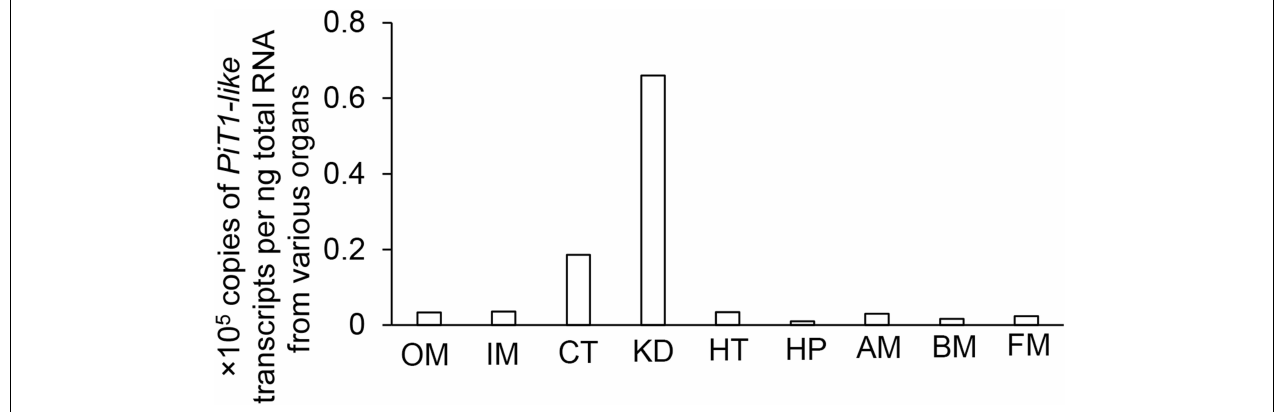
FIGURE 3 | Gene expression of a homolog of sodium-dependent phosphate transporter protein 1 ( PiT1-like ) in the outer mantle (OM), inner mantle (IM), ctenidium (CT), kidney (KD), heart (HT), hepatopancreas (HP), adductor muscle (AM), byssal retractor muscle (BM), and foot muscle (FM) of Tridacna squamosa exposed to light for 12 h.